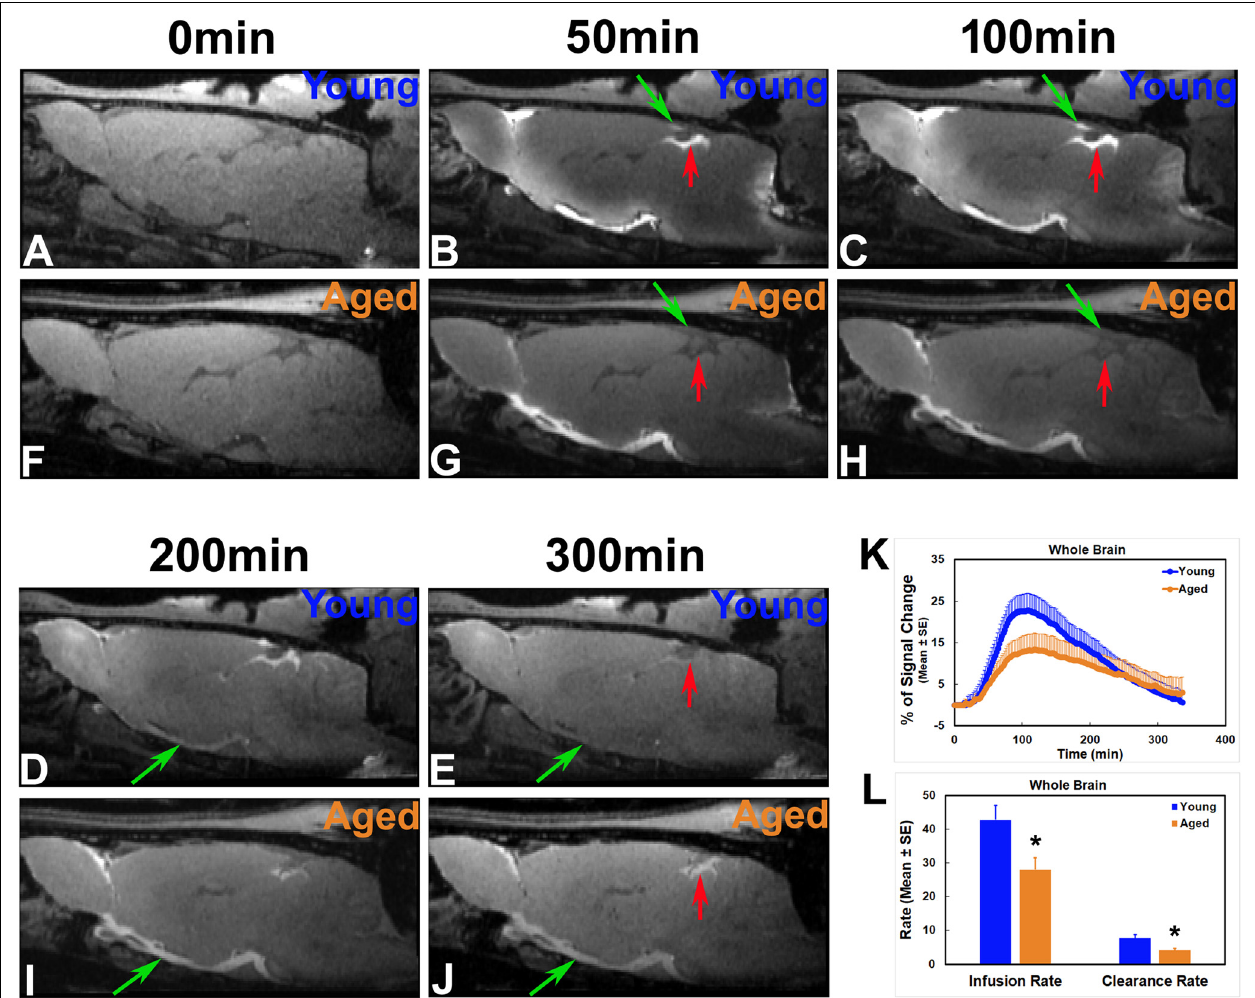
FIGURE 3 | Progressive transport of intracisterna-injected contrast agent in the representative young (A–E) and aged (F–J) rat brain captured by T1WIs ( A–J , Lateral 0.40 mm), group TSCs (K) and parametric quantification (L) . Compared to the young brain, later signal appearance ( B vs. G ; C vs. H at the same areas indicated by green and red arrows, respectively), lower magnitude and narrower extent in tissue enhancement ( B vs. G ; C vs. H in the tissue areas of olfactory bulb and along the base of the brain) and slower clean-out of administered contrast ( D vs. I ; E vs. J at the same areas indicated by green and red arrows, respectively) were observed in the aged brain. Reduced efficiency in both glymphatic influx and efflux was detected in the aged animals than in the young animals as evaluated by TSCs (K) as well as kinetic parameters of infusion and clearance rates (L) . ∗ p < 0.05 (Young vs. Aged).